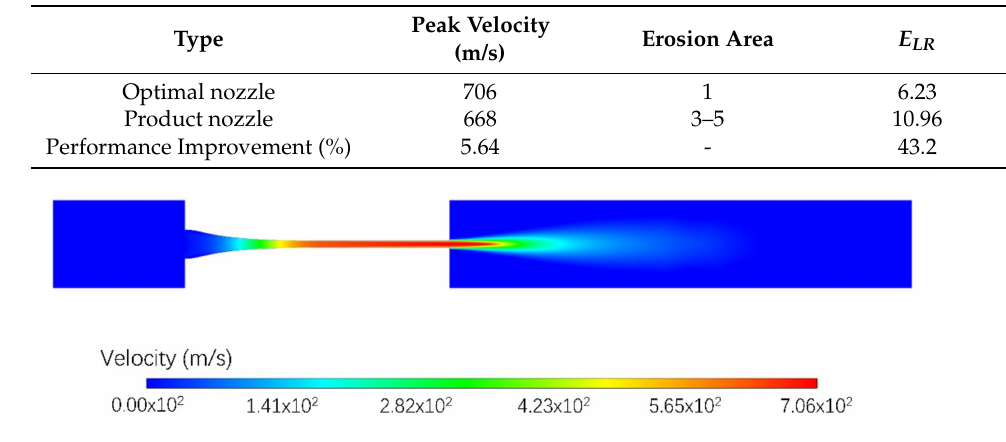
Table 7. Flow state parameters of nozzle with optimum section.